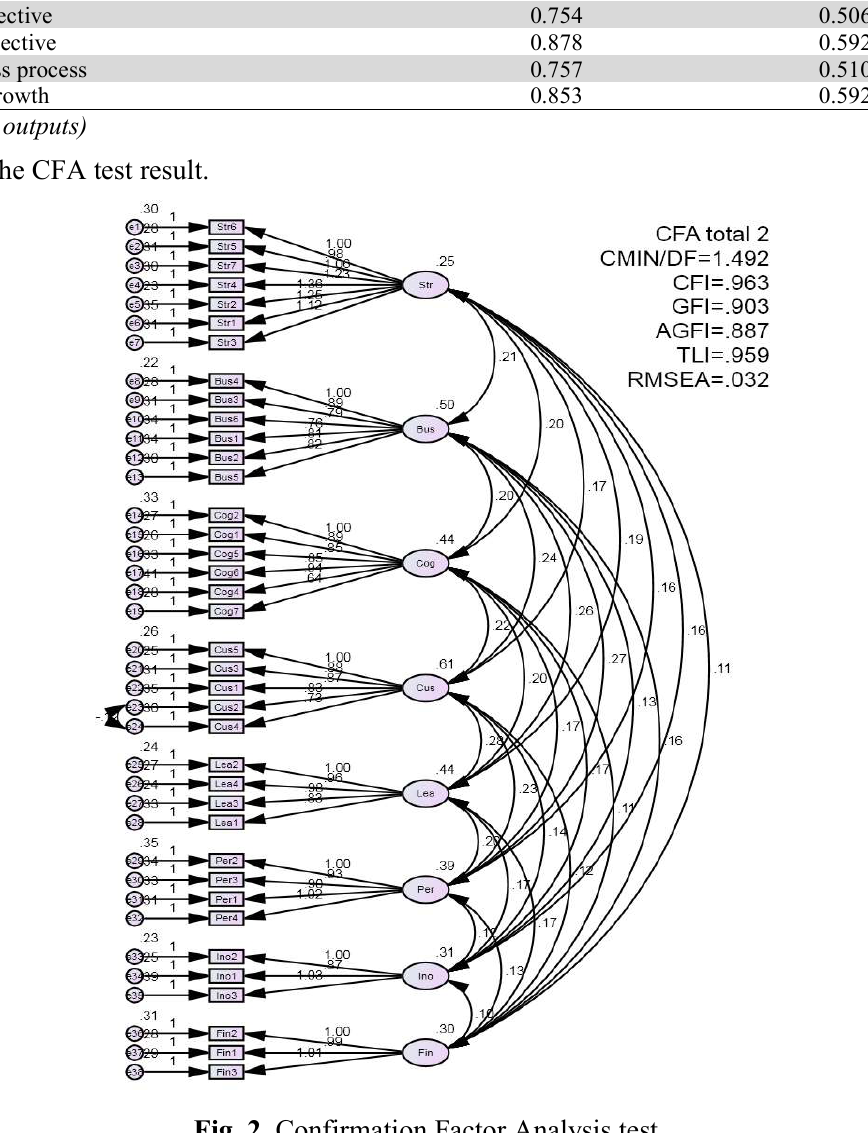
Fig. 2. Confirmation Factor Analysis